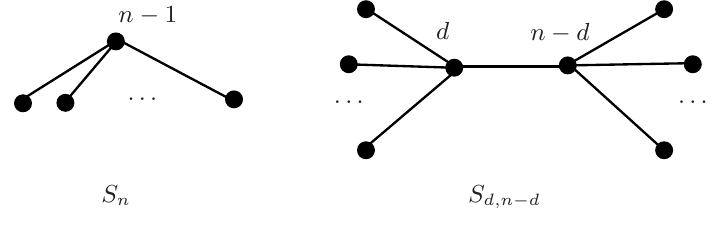
Figure 7: A star and a double